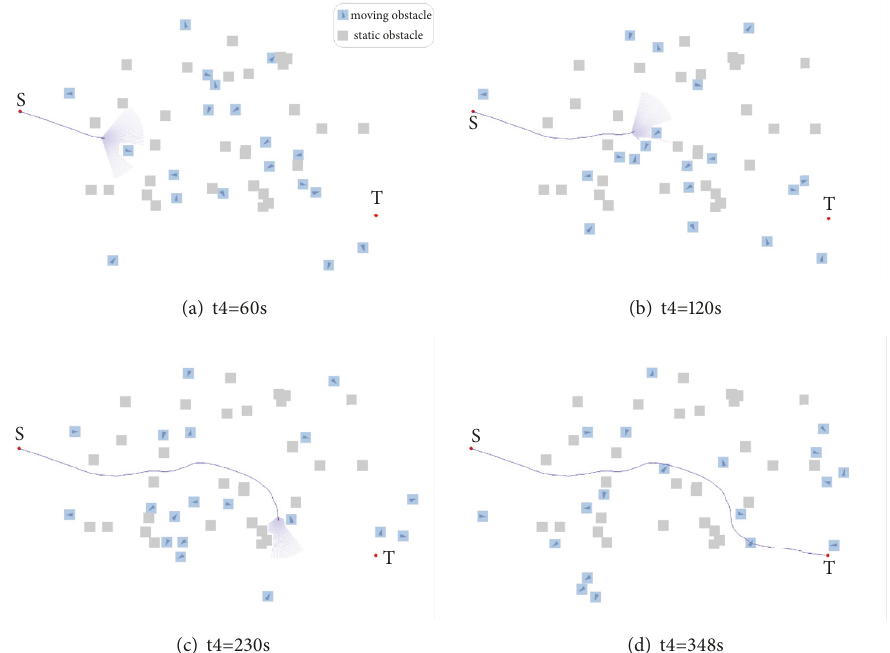
Figure 21: Online planning results of LSTM45 in complex dynamic environments.